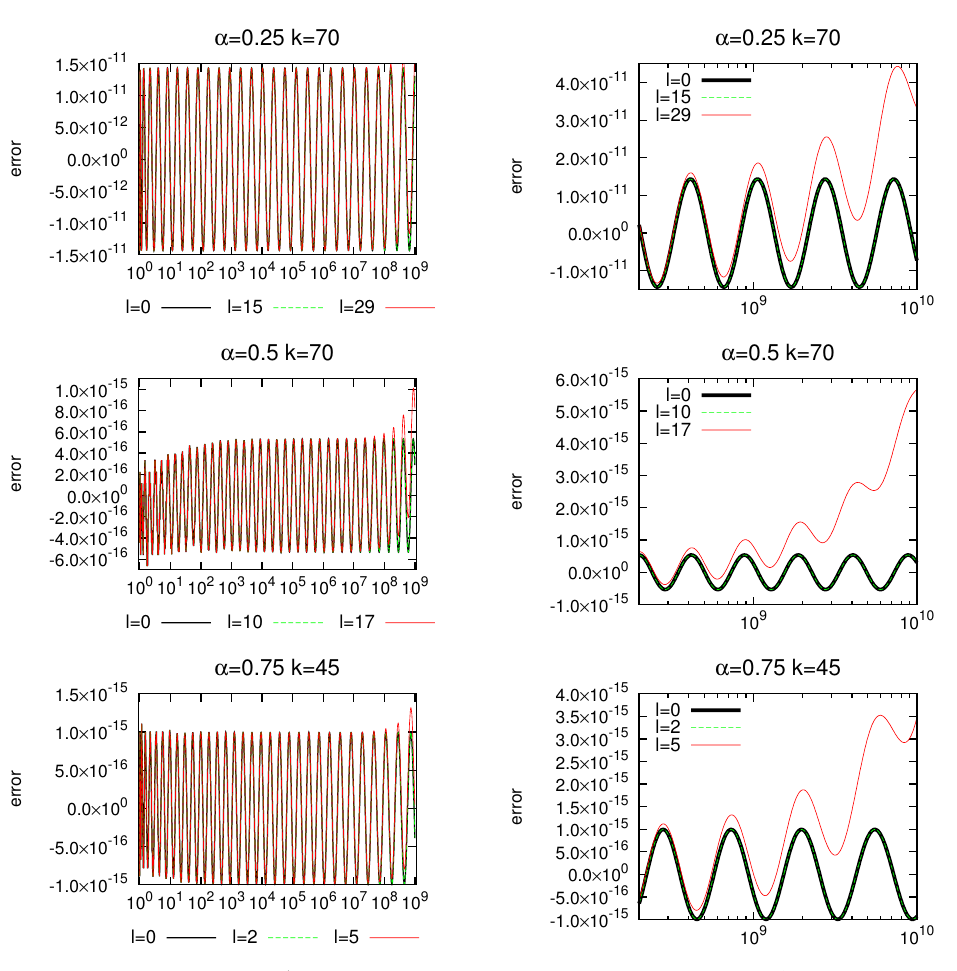
Figure 4. BURA-AR errors ˜ r A k=70, (cid:96) = 0,15,29 ( top ), α = 1